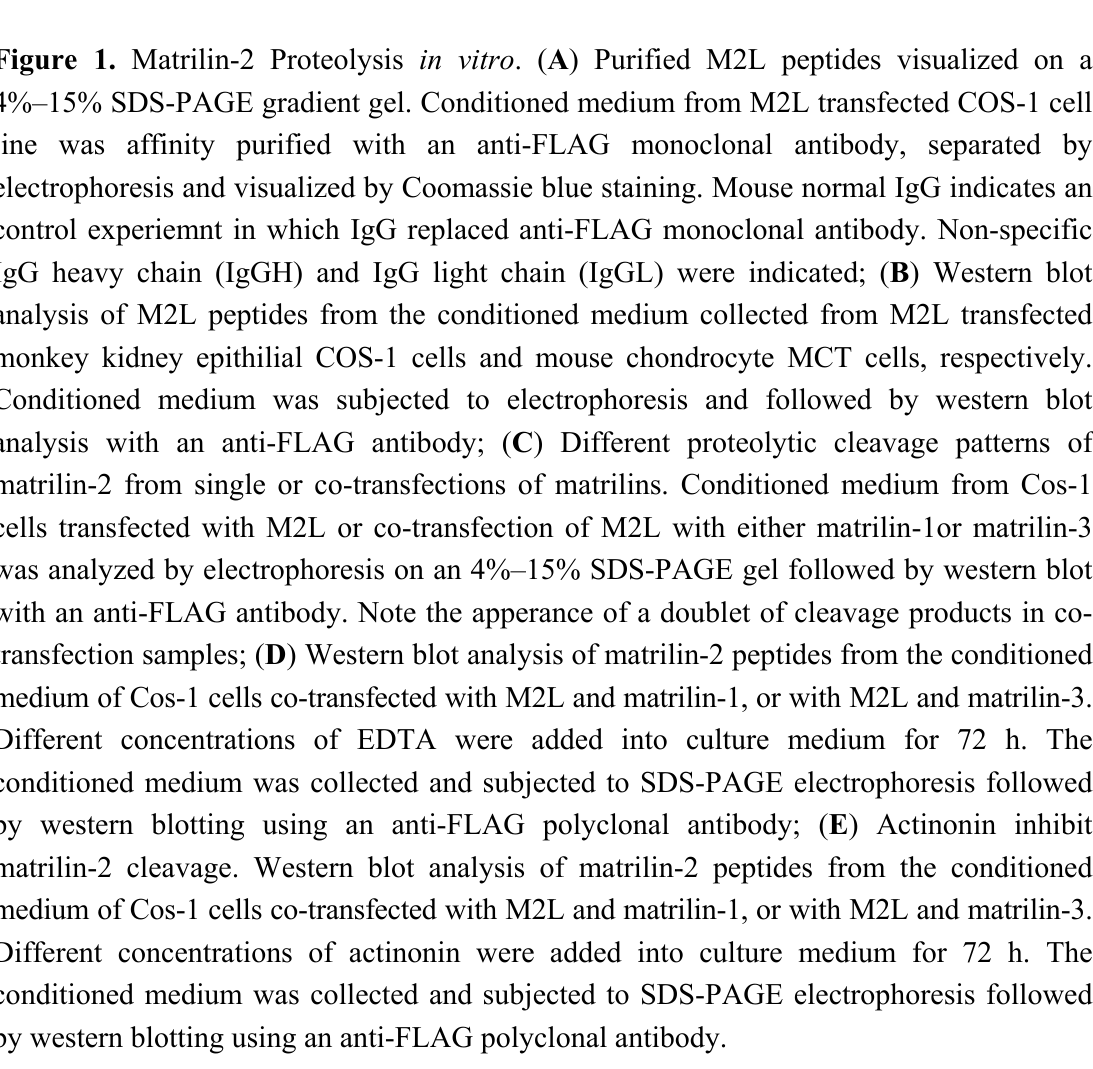
Figure 1. Matrilin-2 Proteolysis in vitro . ( A ) Purified M2L peptides visualized on a 4%–15% SDS-PAGE gradient gel. Conditioned medium from M2L transfected COS-1